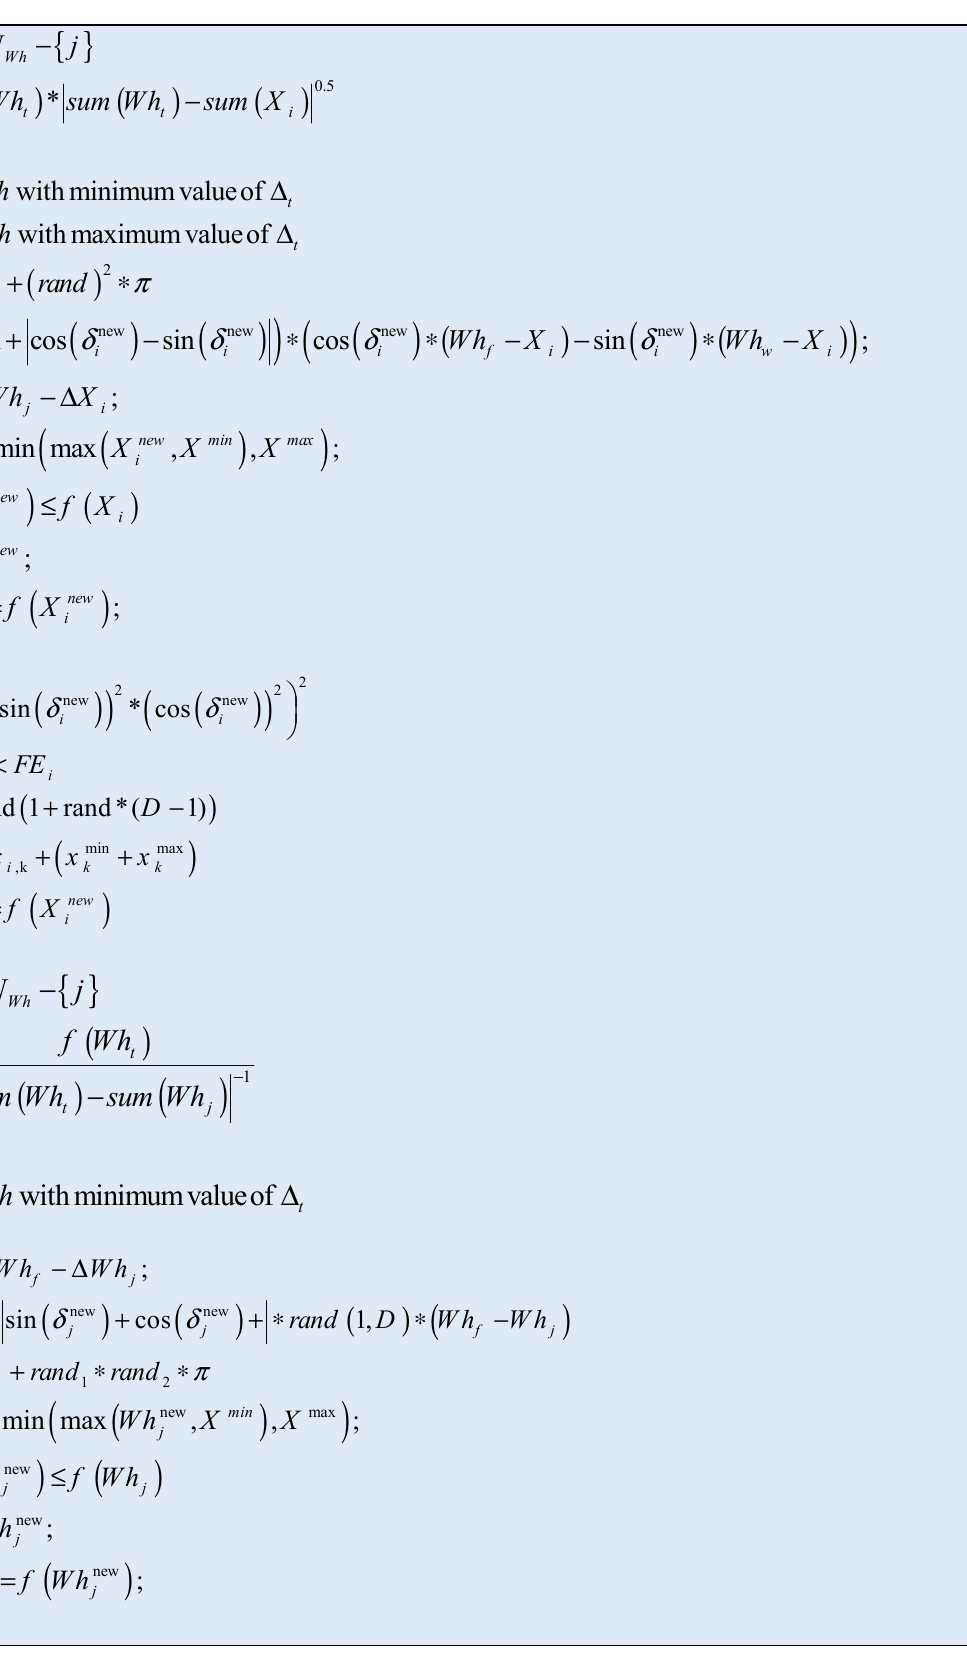
Figure 1. Optimization process of TFWO.